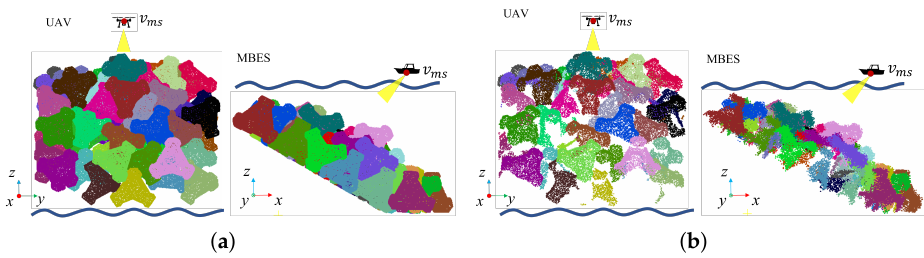
Figure 10. Synthetic point cloud of stacking poses of piled blocks. ( a ) Original set of sampled points on blocks in stacking poses P stack . Point clouds of different block instances are rendered in different colors. ( b ) Point cloud P (cid:48) after removing invisible points and adding artificial Gaussian noise that stack mimics the measurement